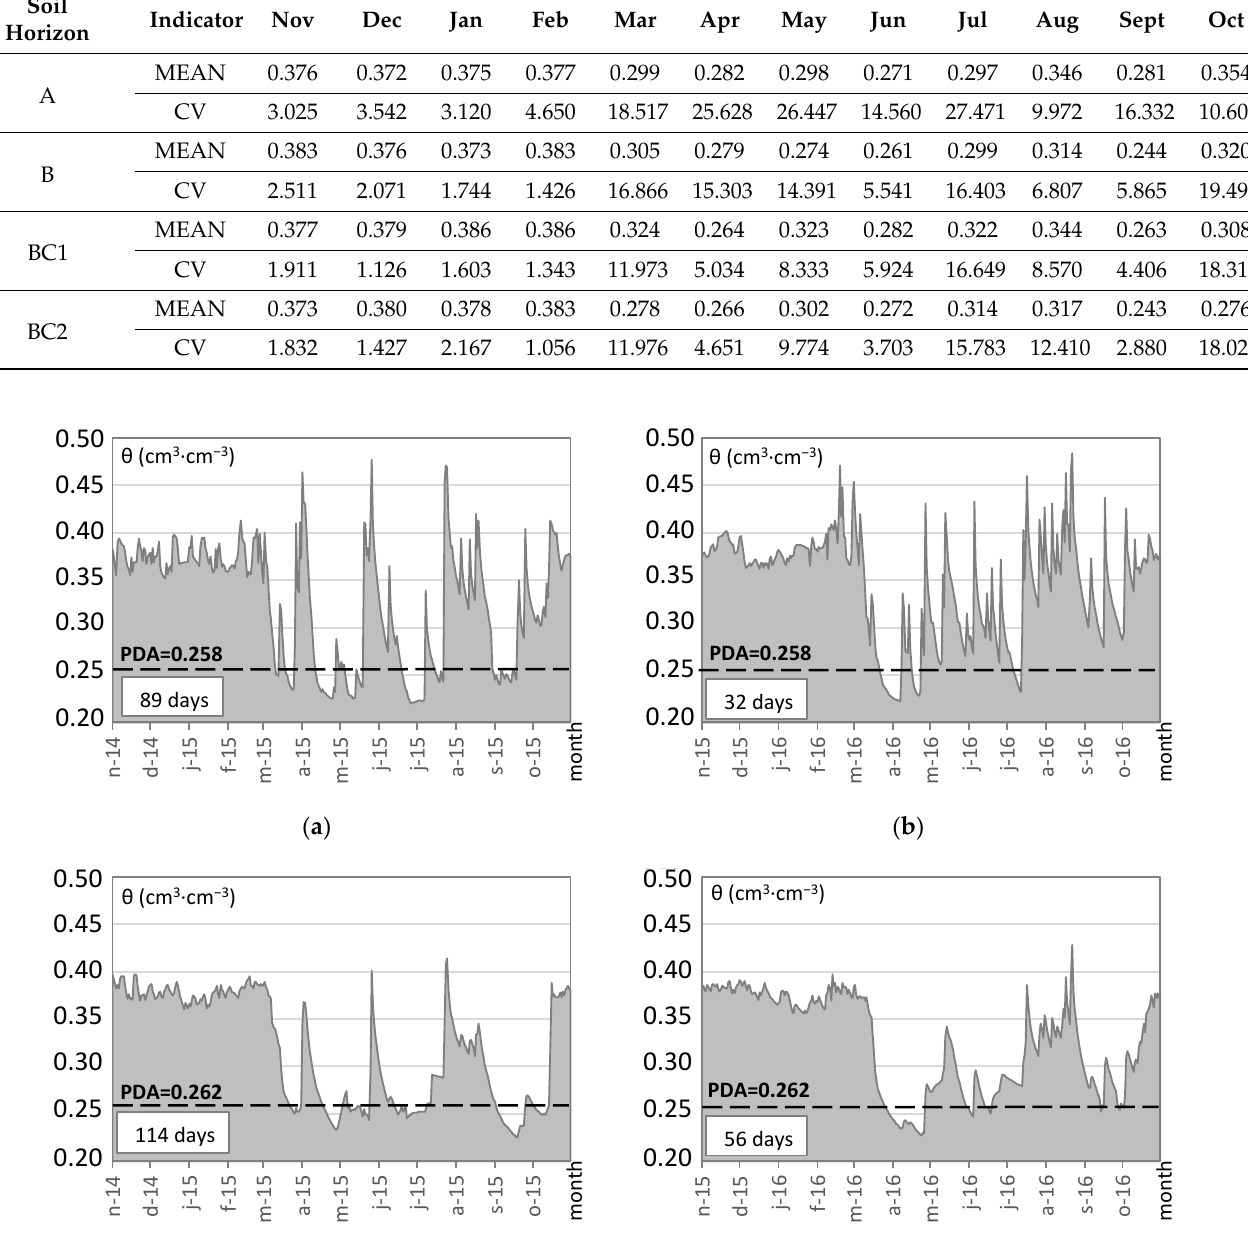
Figure 4. Seasonal changes in the volumetric water content (cm 3 ·cm − 3 ) ( a ) in the A horizon in HY 2015 and ( b ) in HY 2016, ( c ) in the B horizon in HY 2015 and ( d ) in HY 2016 and their relation to the PDA hydrolimit (dashed line). The sum of the days under the PDA is stated in the box under the dashed line.